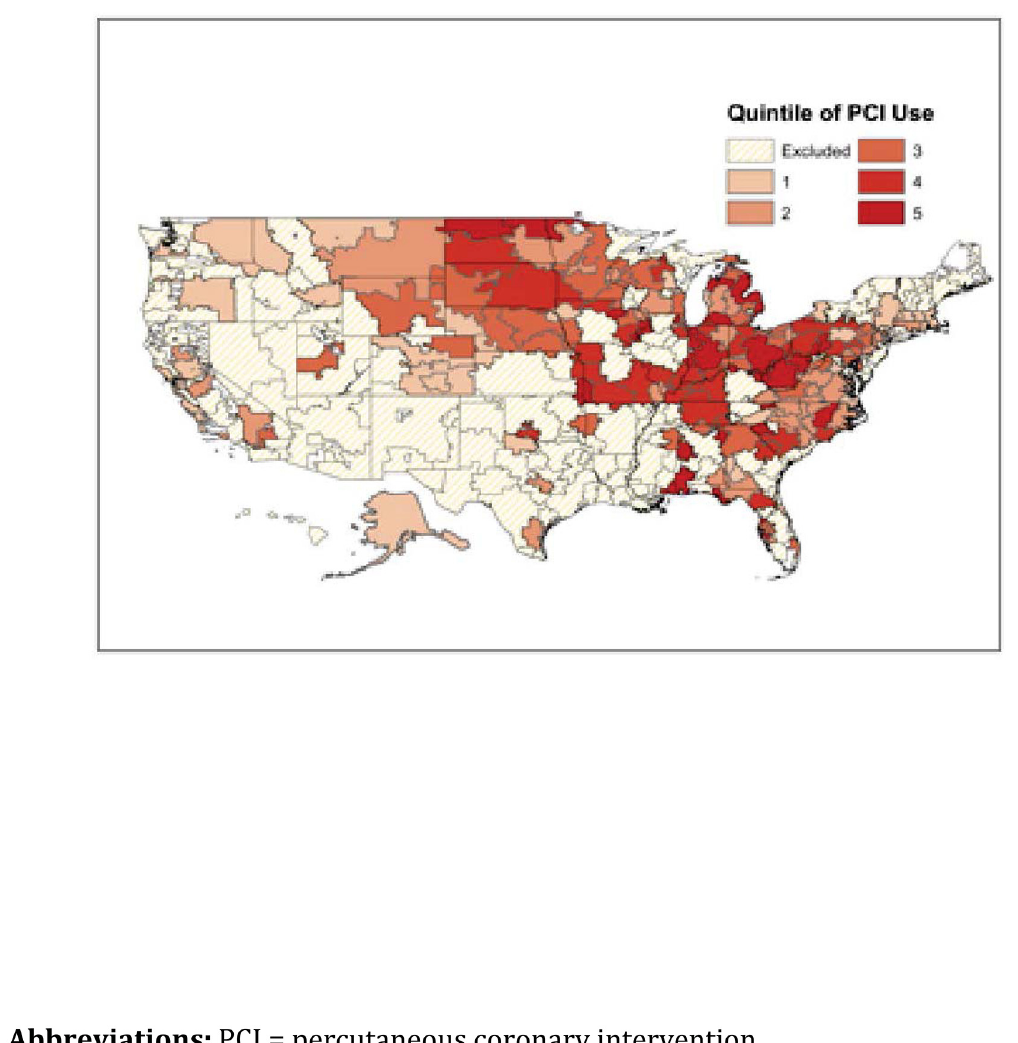
Fig 2. Geographic distribution of HRRs categorized by quintiles of PCI utilization and included in analysis. Shown are the HRRs divided by quintile of PCI utilization and the HRRs that were excluded from the analysis.